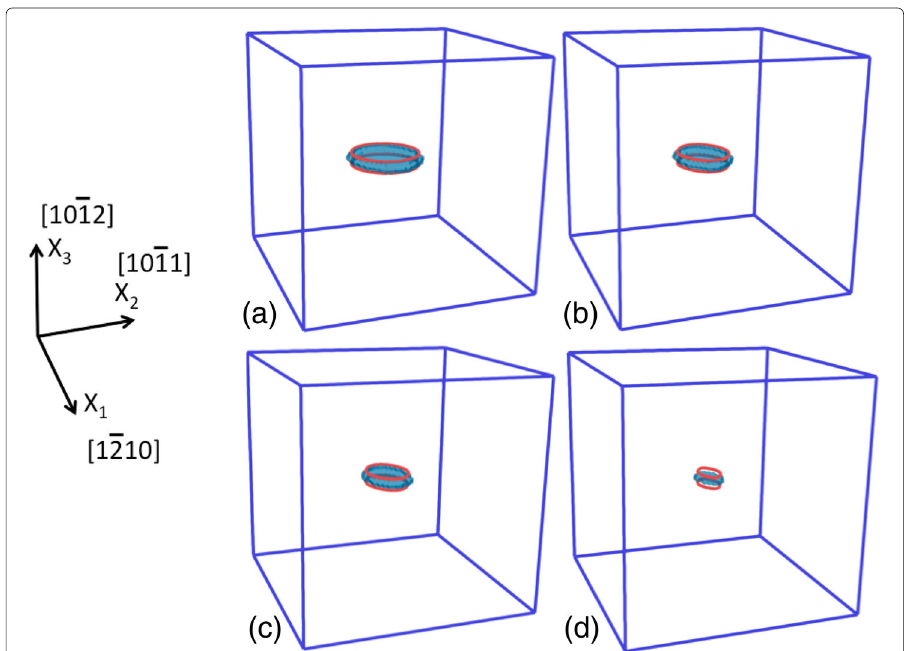
Fig. 5 Self-shrinkage in the transverse direction of a ( 10 ¯ 12 ) twin. The twin is modelled by a dipole of disclination loops (red solid lines). From ( a ) to ( d ): Progressive self-shrinkage of the twin. In blue colour is shown the plastic rotation around X 1 . Only plastic rotation values smaller than -0.06 rad are shown